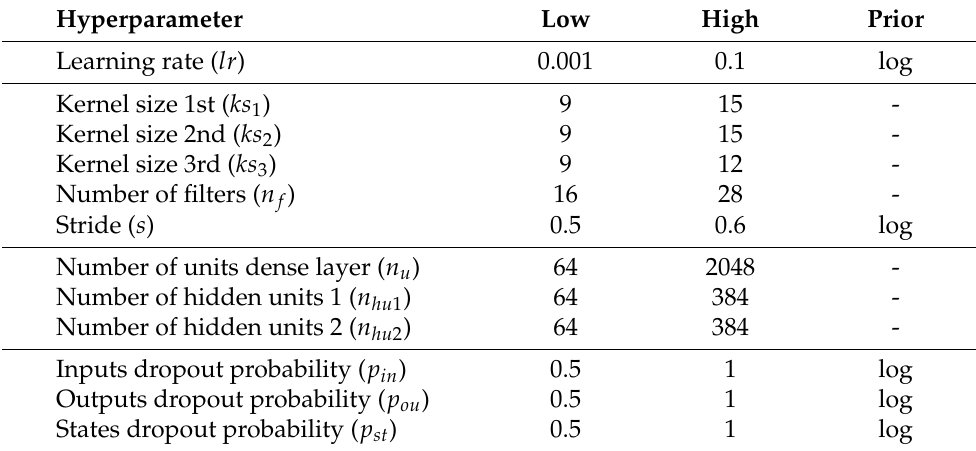
Table 1. Hyperparameters of the architectural components and their associated ranges used for the construction of the surrogate model. From [109]. Hyperparameter Low High Prior Learning rate ( lr )